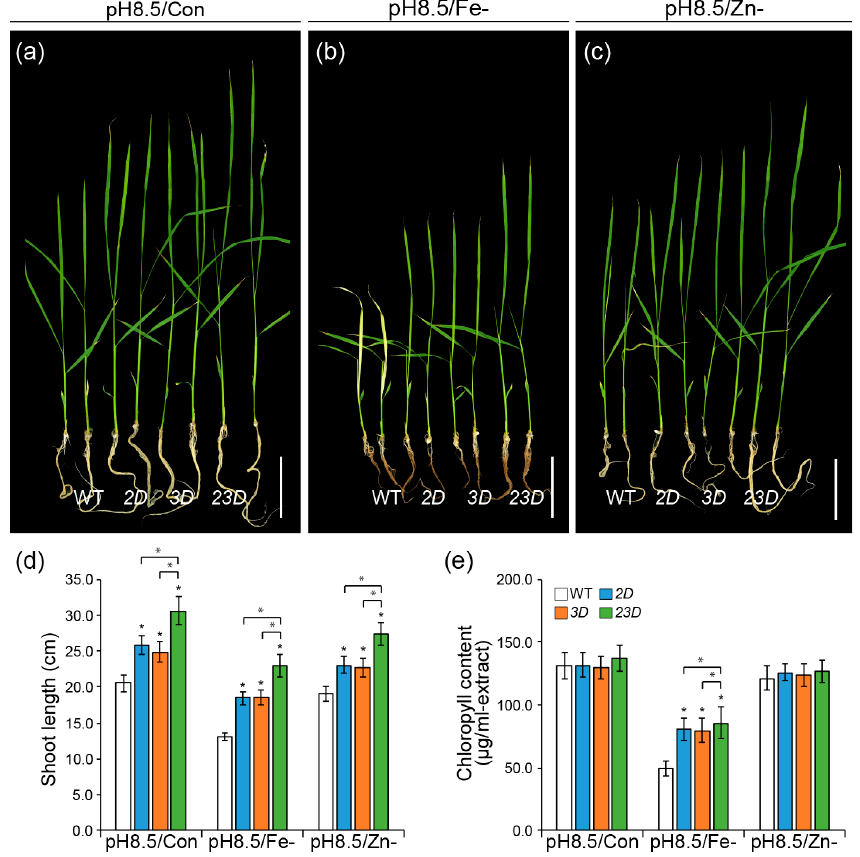
Figure 4. Comparison of seedling growth test under high pH conditions. ( a – c ) Phenotypes of WT, 2D , 3D , and 23D grown on alkaline Yoshida solution (( a ) pH 8.5), without Fe (( b ) p H8.5/Fe-), or without Zn (( c ) p H8.5/Zn-) for 15 days. Bars = 5 cm. Shoot lengths ( d ) and total chlorophyll concentrations ( e ) of WT and activation-tagged mutants. Data are mean ± SE (n = 8 for shoot length; n = 4 for chlorophyll content), and significant differences among mutants and WT plants are indicated with an asterisk (* p < 0.05 by Student’s t -test).